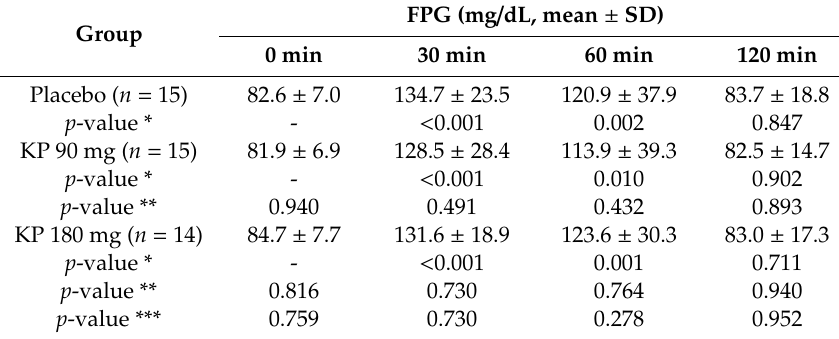
Table 2. Blood glucose levels of volunteers after glucose loading at